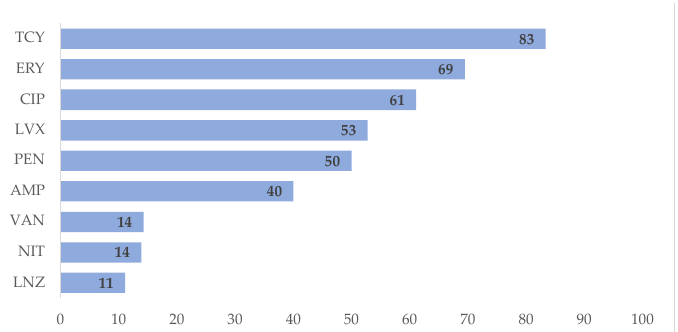
Figure 2. Antimicrobial resistance patterns in Enterococcus spp. isolates at Yangon General Hos- pital, Myanmar, in 2018. X-axis represents the percentage of resistance. AMP = Ampicillin, CIP = Ciprofloxacin, ERY = Erythromycin, GEN = Gentamicin, LNZ = Linezolid, NIT = Nitrofurantoin, PEN = Penicillin, TCY = Tetracycline, VAN = Vancomycin. Of all Acinetobacter baumannii isolates, 90% were resistant to ciprofloxacin, 89% to piperacillin/tazobactam and 82% to trimethoprim/sulfamethoxazole. Pseudomonas aerugi- nosa showed resistance to ciprofloxacin (84%), levofloxacin (82%) and gentamicin (76%). Burkholderia cepacia was commonly resistant to levofloxacin (80%), trimethoprim/ sulfamethoxazole (70%), and Meropenem (63%) (Figure 3). Trop. Med. Infect. Dis. 2021 , 6 , x FOR PEER REVIEW